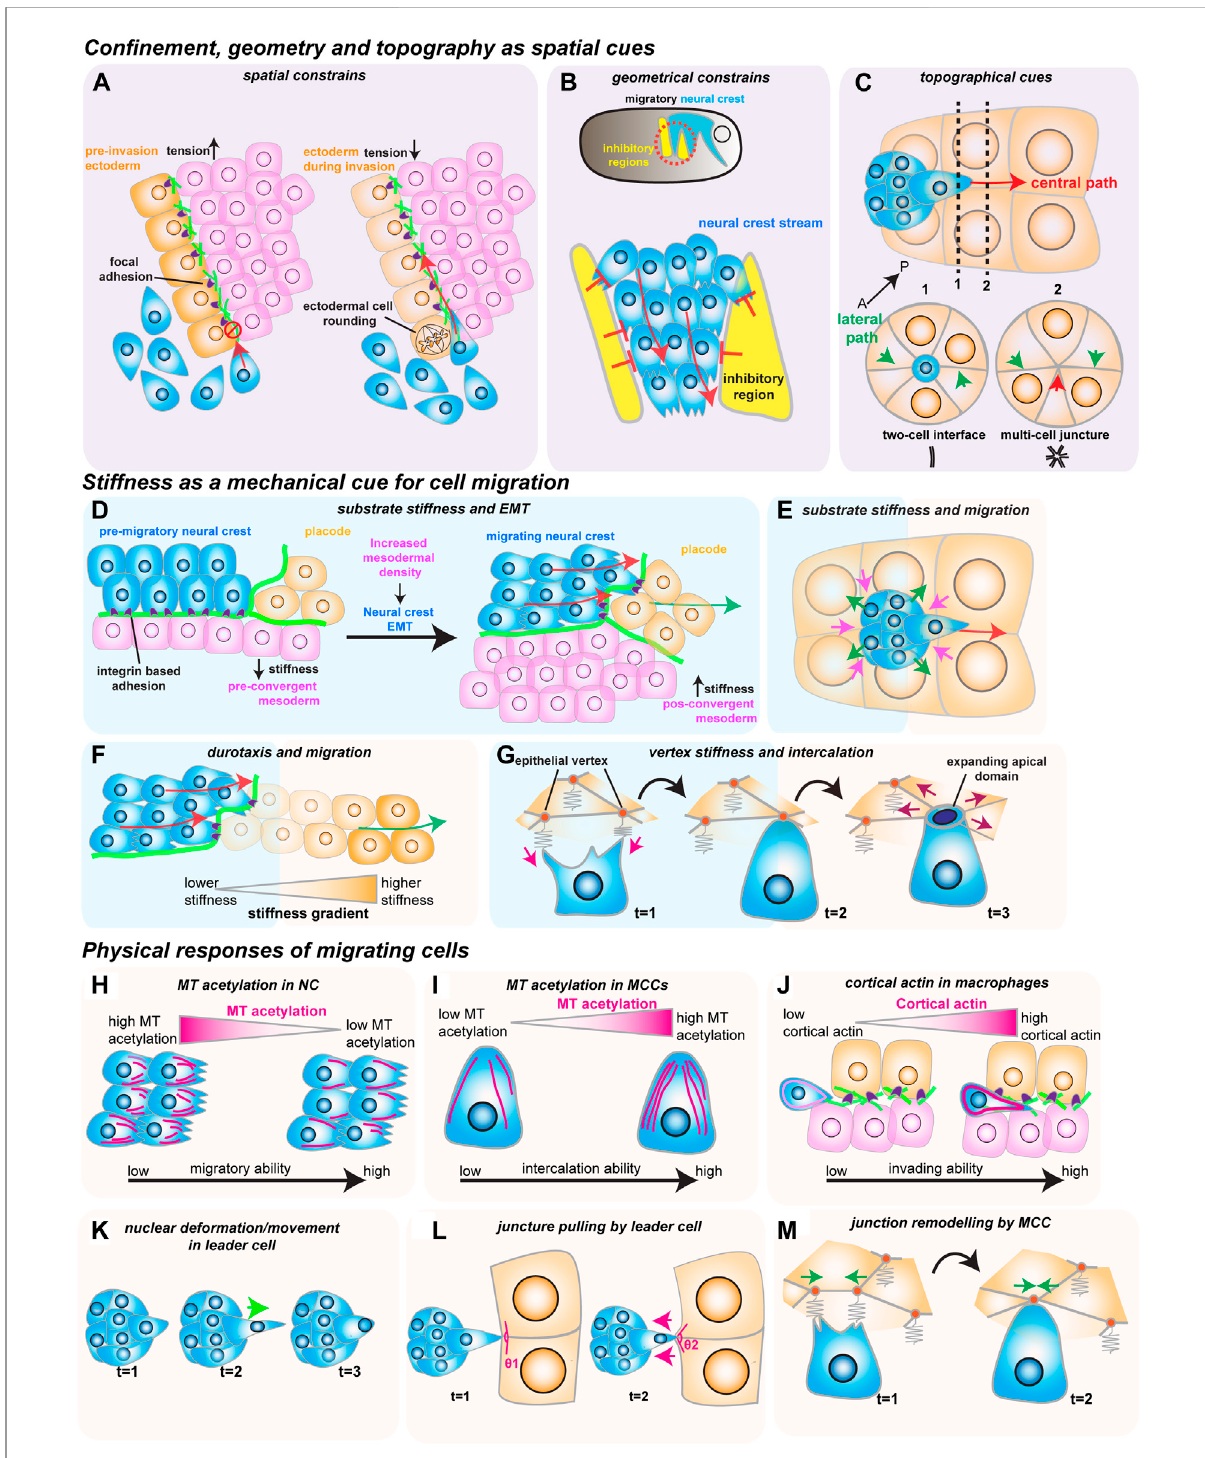
FIGURE 2 How mechanical cues impact cell migration in vivo . The red arrows show the direction of migrating cells. (A – C) Con fi nement, geometry and topography as spatial cues. (A) Spatial constraints block macrophage invasion (in blue) by controlling cells ’ ability to crawl through the ectoderm (in orange) and the mesoderm (in magenta). Decreasing ectodermal tension is paired with ectodermal cell rounding to promote macrophage invasion. Ectodermal cell rounding removes focal adhesions (in purple) that act as an impediment to cell movement. (B) Geometric constraints control stream formation in the neural crest (in blue). Inhibitory signals (in yellow) regulate where NC can move, stopping NC cell dispersion and promoting